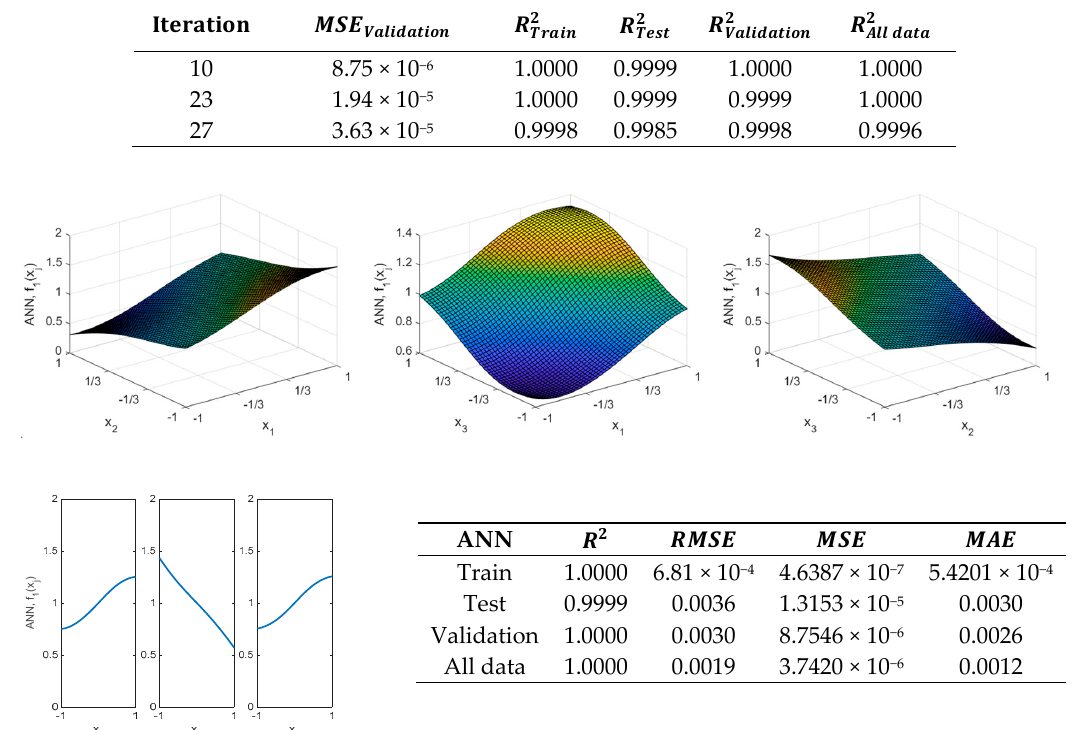
Figure 10. Response surfaces obtained, main effects plot and results of the validation metrics obtained with the ANN model for the case of type 1 function ( f 1 ) ( n = 8 neurons ) .